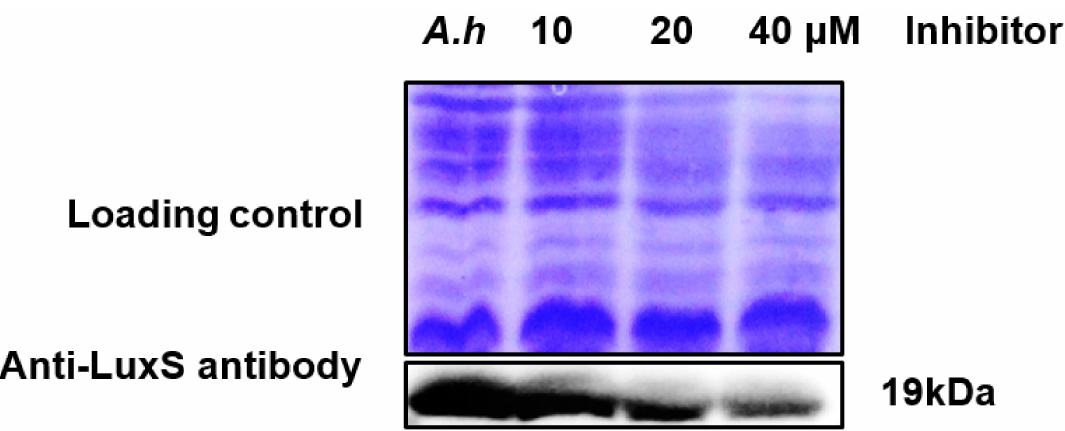
Figure 8. Validation of LuxS protein expression levels with Western blotting using increasing concentrations of a LuxS inhibitor compound. A. hydrophila was treated and untreated ( A.h , wild type used as a control) with increasing inhibitor concentrations of 10, 20, and 40 µ M (lower panel). Coomassie R-350 staining of the membrane shows equal loading of the protein sample (upper panel). 2.11. The Mixture of OXY and AI-2 Inhibitor Is a Potentially Synergistic Strategy for